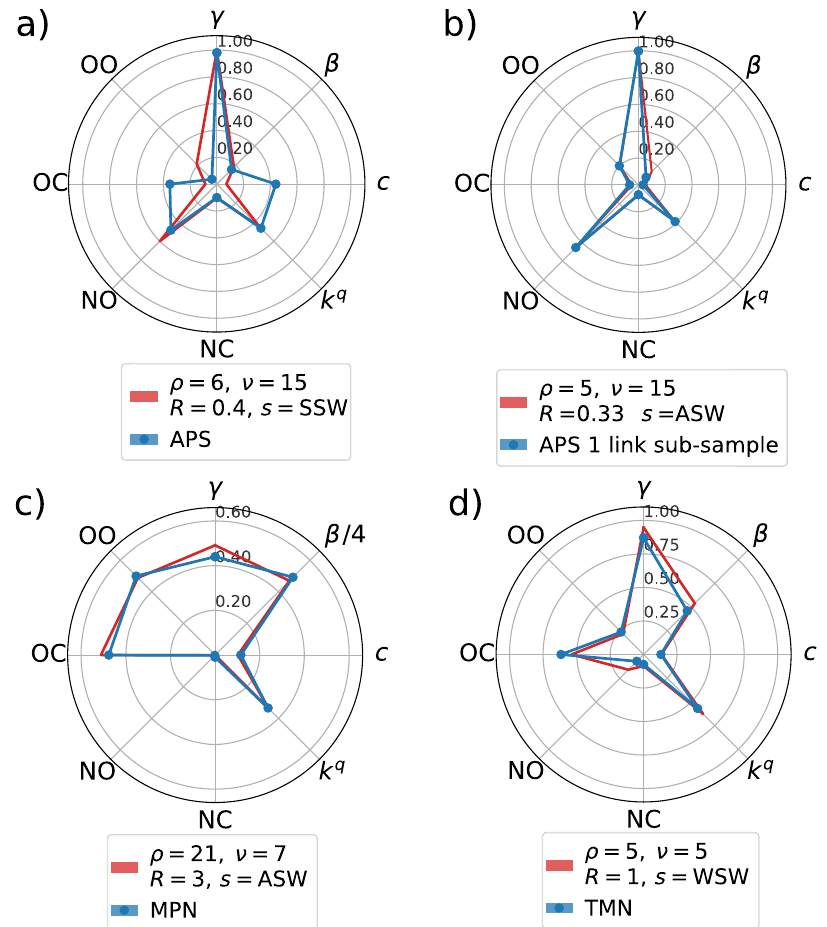
Fig. 4 Eight selected observables for model ’ s optimisation. a – d Radar plots comparing eight selected observables measured in empirical (blue lines) and synthetic data (red lines). In each panel, we report the reinforcement and novelties parameters ρ and ν and their ratio R as well as the optimal sampling strategy s , that is: ( a ) American physical society (APS) with the symmetric sliding window (SSW) strategy s , ( b ) the 1-link subsampled APS with the asymmetric sliding window (ASW) strategy, ( c ) the mobile phone network (MPN) fi tted with the ASW strategy, and, ( d ) the Twitter mentions network (TMN) with the weighted sampling with withdrawal (WSW)